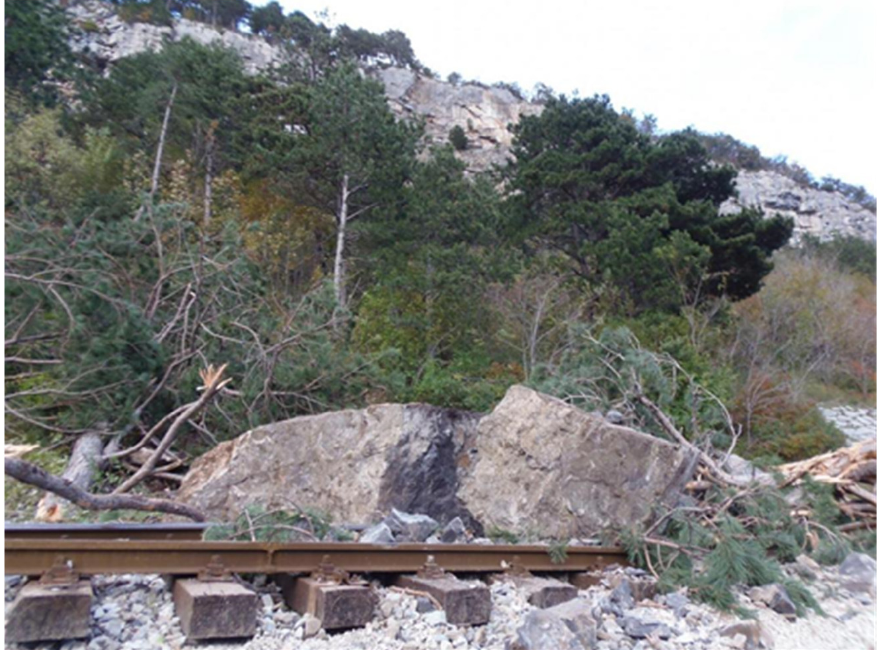
Figure 5. Photo of the rockfall originating from the Raspadalica Cliff on 16 December 2013.